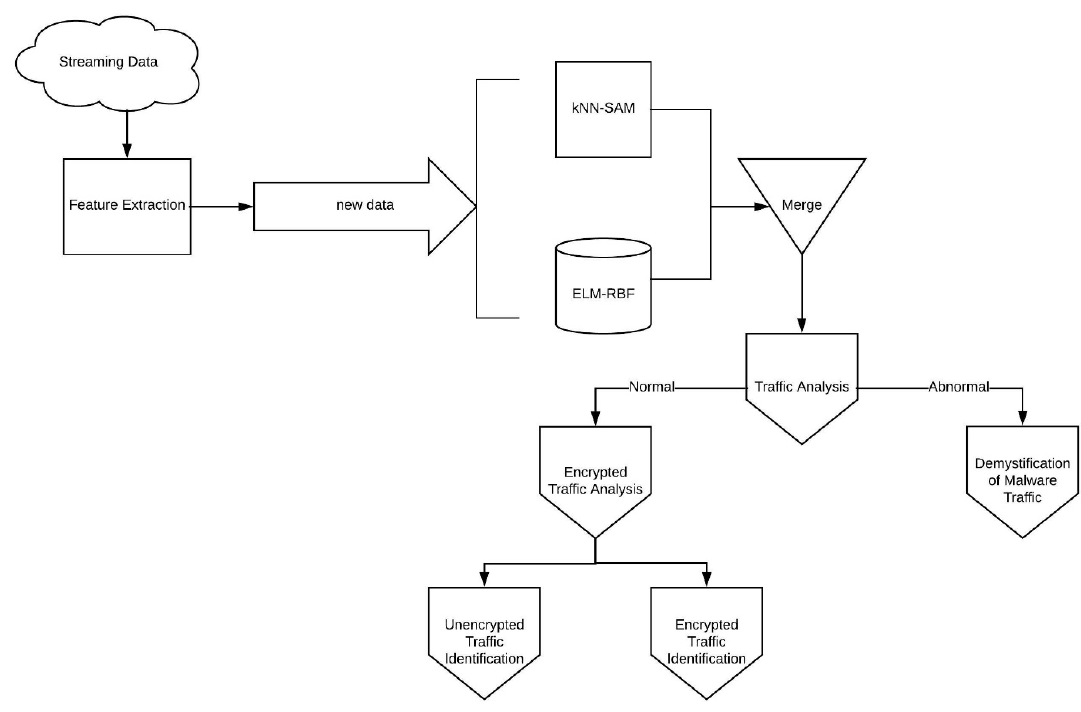
Figure 2. The algorithmic process of the proposed λ-NF3.